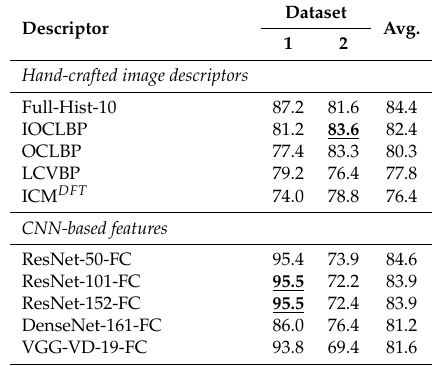
Table 12. Results of Experiment #6: non-stationary textures with rotation. Figures report overall accuracy by dataset. Boldface denotes the highest value; underline signals a statistically-significant difference between the best hand-crafted and the best CNN-based descriptor. Descriptors are listed in ascending order of by-experiment rank (best first).